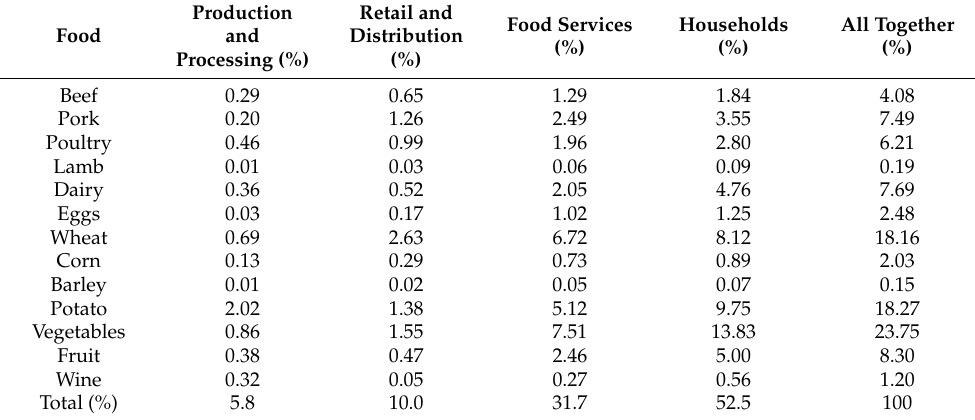
Table 2. Distribution of food losses and waste by type of food and stages of the supply chain (linked to a total amount of 125 kt). Food